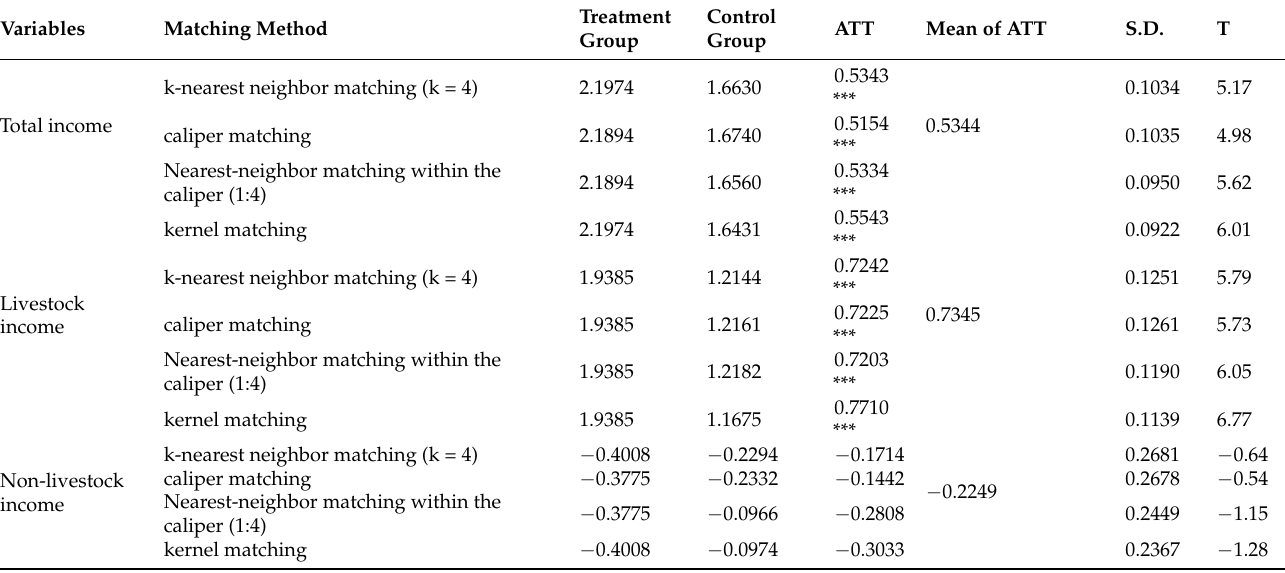
Table 6. PSM results of grassland rent-in on herder income.